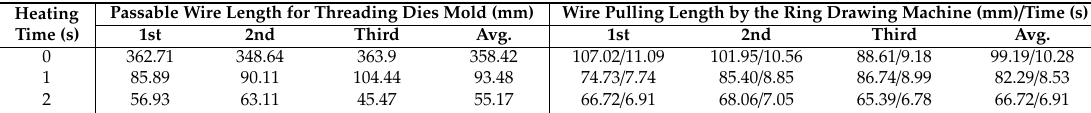
Table 5. Results based on wire pulling speed: k5(9.65 mm /